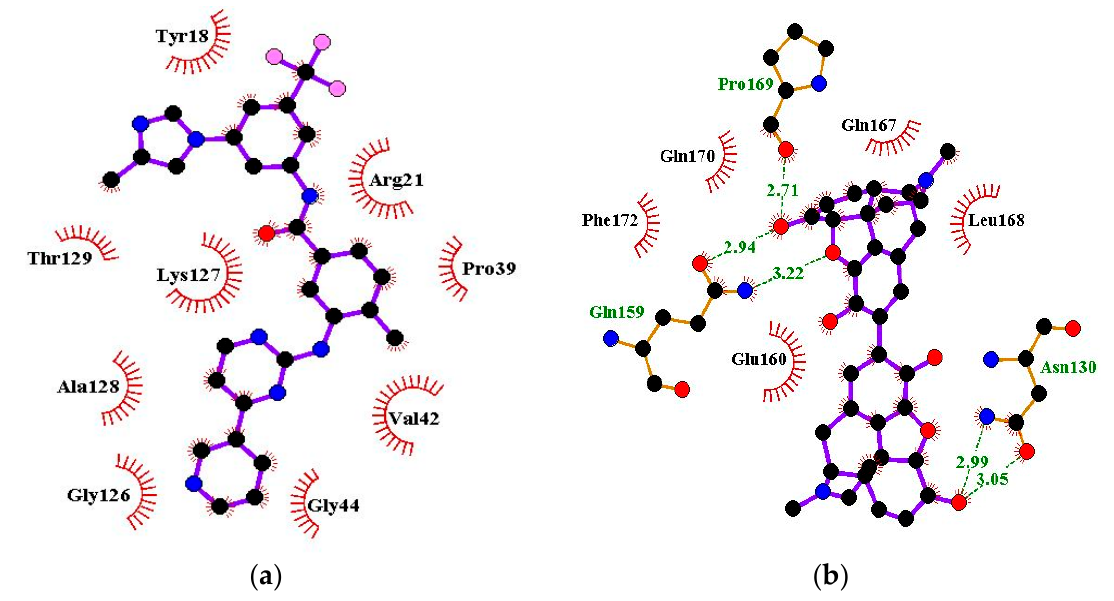
Figure 3. Protein–ligand interaction map of VP40 in complex with ( a ) nilotinib and ( b ) ZINC000085531689. The green, dotted lines indicate hydrogen bonds while the red arcs with spikes represent hydrophobic interactions.